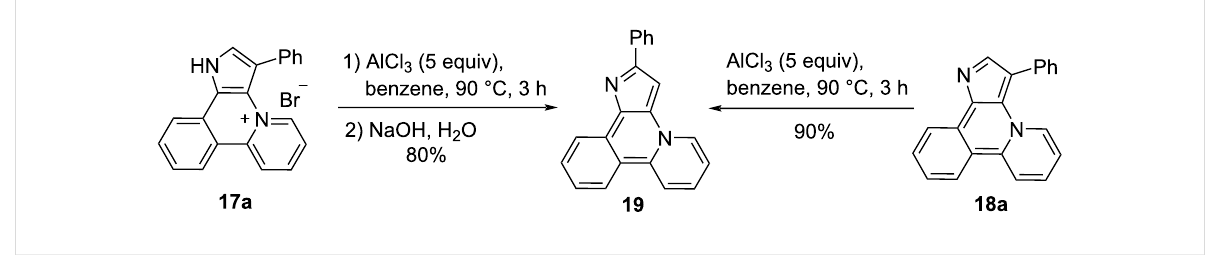
Scheme 6: Isomerization of compounds 17a and 18a .